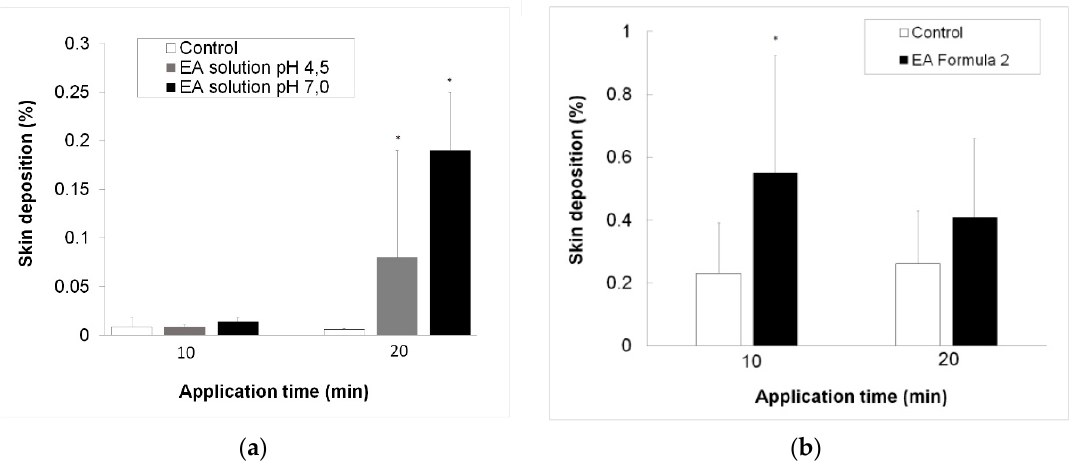
Figure 6. ( a ) Comparison of the deposition of 0.2% EA solution at pH 4.0 and pH 7.0 at 0.3 mA/cm 2 applied for 10 min and 20 min iontophoresis; ( b ) comparison of the deposition of 0.5% EA Formula 2 at pH 4.8 at 0.3 mA/cm 2 applied for 10 min and 20 min. The amounts of EA deposited are expressed as percentages of the amounts applied to the skin ( n = 6). * Denotes statistically significant difference with respect to the control at the corresponding application time.